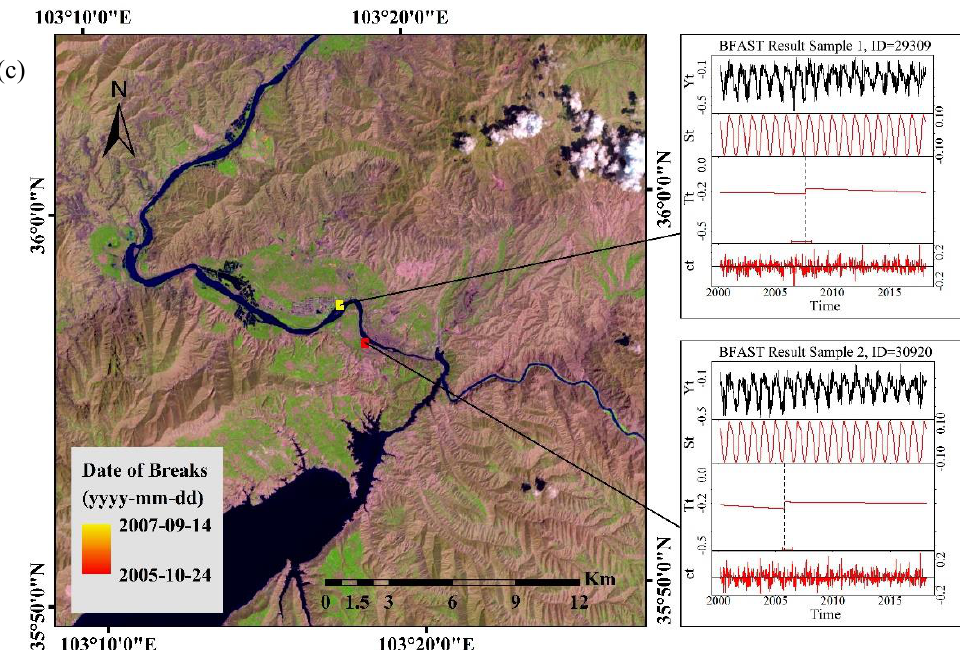
Figure 8. Unfiltered false break points detected in terrestrial areas away from the Yellow River ( a ), near Liujiaxia reservoir ( b ), and in the Yellow River ( c ). From the plots of trend component, what could be discovered is that the values in trend components jumped to a little higher value than the threshold we set. With a little higher value of threshold, these false break points would be effectively eliminated, which is the inherent disadvantage of threshold-based elimination.